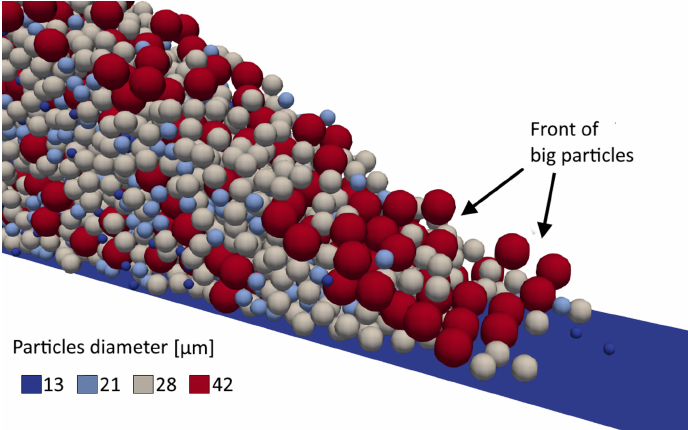
Figure 7. Snapshot of the base of the powder heap, where a front formed by the bigger particles can be observed. The picture is referred to a 20mm/s spreading